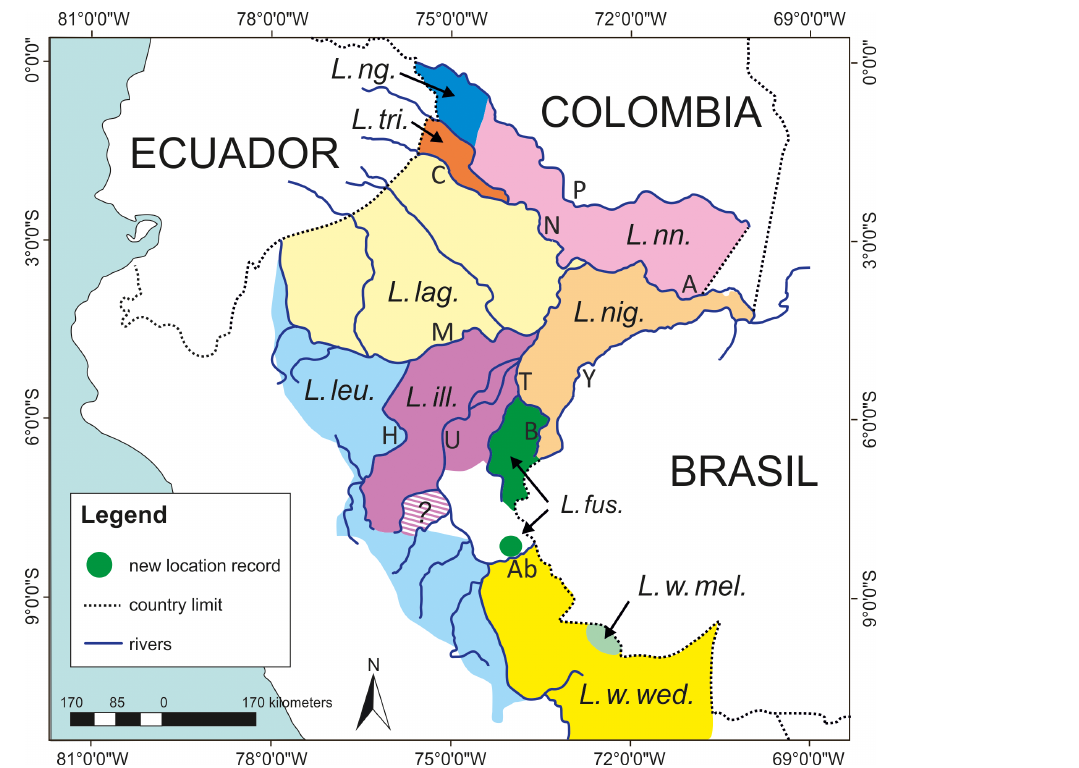
Figure 3. Geographic distribution of Leontocebus taxa in Peru and the new location record for Leontocebus fuscicollis (green dot). L.fus. – Leontocebus fuscicollis fuscicollis ; L.ill. – Leontocebus illigeri ; L.lag. – Leontocebus lagonotus ; L.leu. – Leontocebus leucogenys ; L.ng. – Leontocebus nigricollis graellsi ; L.nig. – Leontocebus nigrifrons ; L.nn. – Leontocebus nigricollis nigricollis ; L.tri. – Leontocebus tripartitus